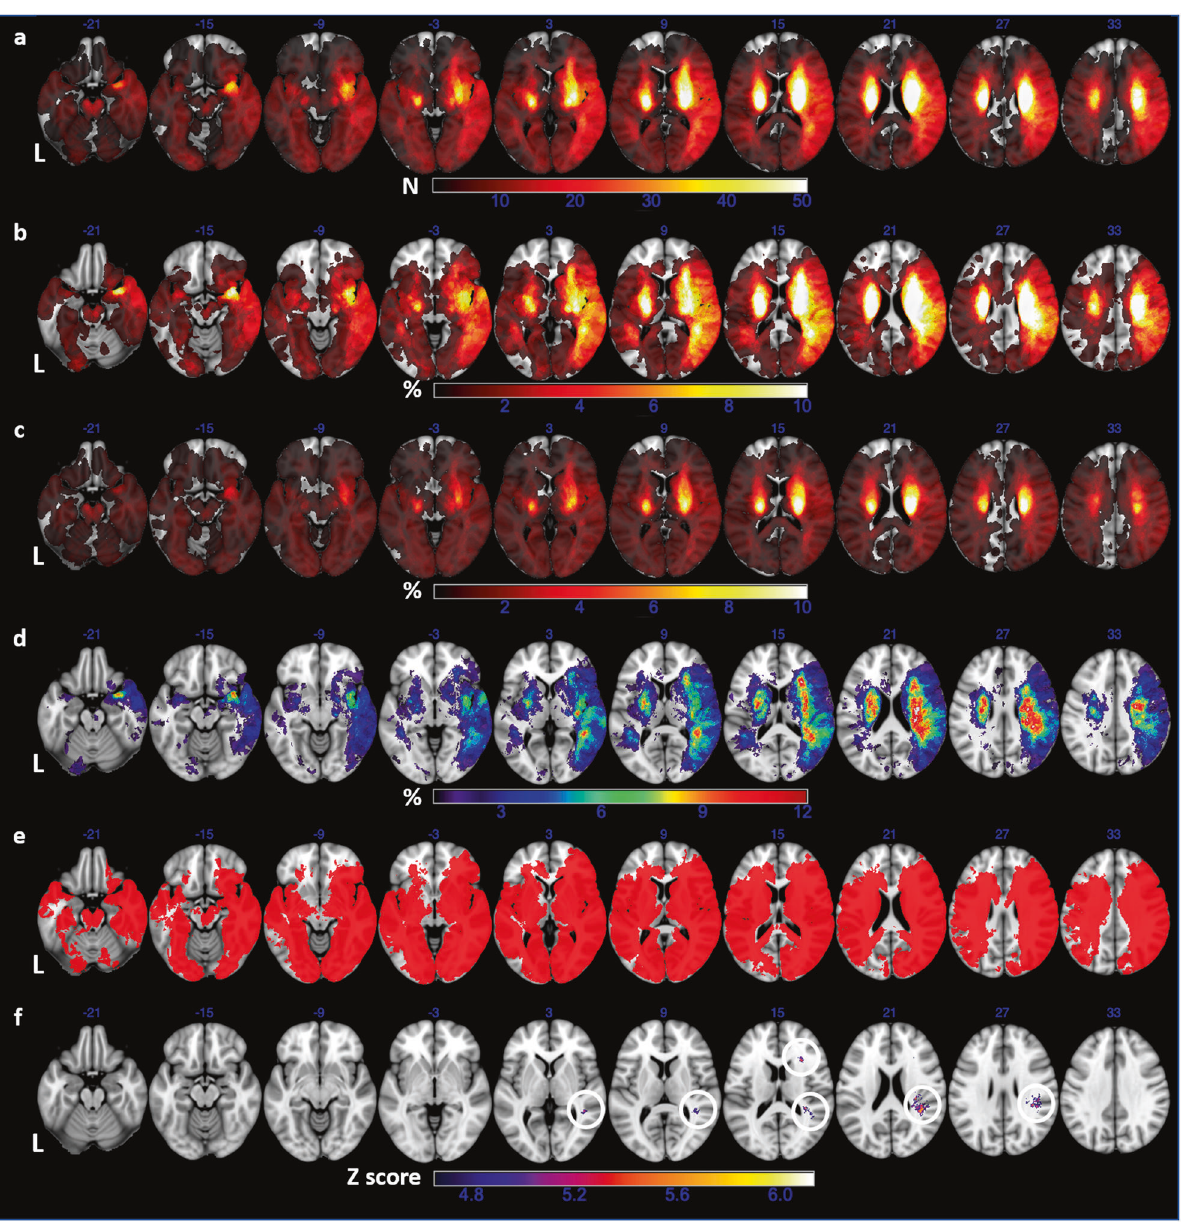
Fig. 1 Results of Lesion Analyses. a overlap of all 697 lesion masks showing lesion frequency of the entire sample; b lesion prevalence(%) in PSD group; c lesion prevalence(%) in non-PSD group; d lesion subtraction plot ( b minus c ); e only voxels involving at least 5 patients were included in VLSM (red); f signi fi cant clusters (circled) from VLSM that survived FWE-corrected Z threshold of 4.65 and cluster size threshold of 22. Axial coordinates refer to MNI space in mm. L indicates or vascular depression can be signi fi cantly alleviated after Applying novel disconnectome technique and voxel-wise repetitive transcranial magnetic stimulation targeted at DLPFC analysis, we identi fi ed the association between SDC of certain [37, 38]. LNM analysis also identi fi ed a functional depression circuit white matter regions and PSD (Fig. 2). First, SDC within bilateral centered on the DLPFC [5]. Fourth, we found the association temporal white matter may be associated with PSD. A prior study between posterior corpus callosum disconnection and PSD, showed the similar result that lesions in temporal lobes were though the role of posterior corpus callosum disconnection in associated with PSD three months poststroke [33]. Reduced gray MDD had been described [39]. The posterior corpus callosum, matter volume of superior and middle temporal gyri were connecting bilateral temporal, parietal and occipital cortices, may observed in MDD [34]. Second, SDC next to bilateral limbic play a vital role in maintaining stable functional communication structures (hippocampi and amygdalae) and bilateral prefrontal between hemispheres [40]. Fifth, signi fi cant voxels were observed cortex are associated with PSD in our study, which is in line with next to bilateral posterior parietal cortex which is one of the major the fronto-limbic model described in MDD [35] and vascular associative regions in human brain and integrates information depression [36]. The role of prefrontal cortex in depression has from somatosensory, auditory, visual, motor, cingulate and been con fi rmed by studies demonstrating that symptoms of PSD